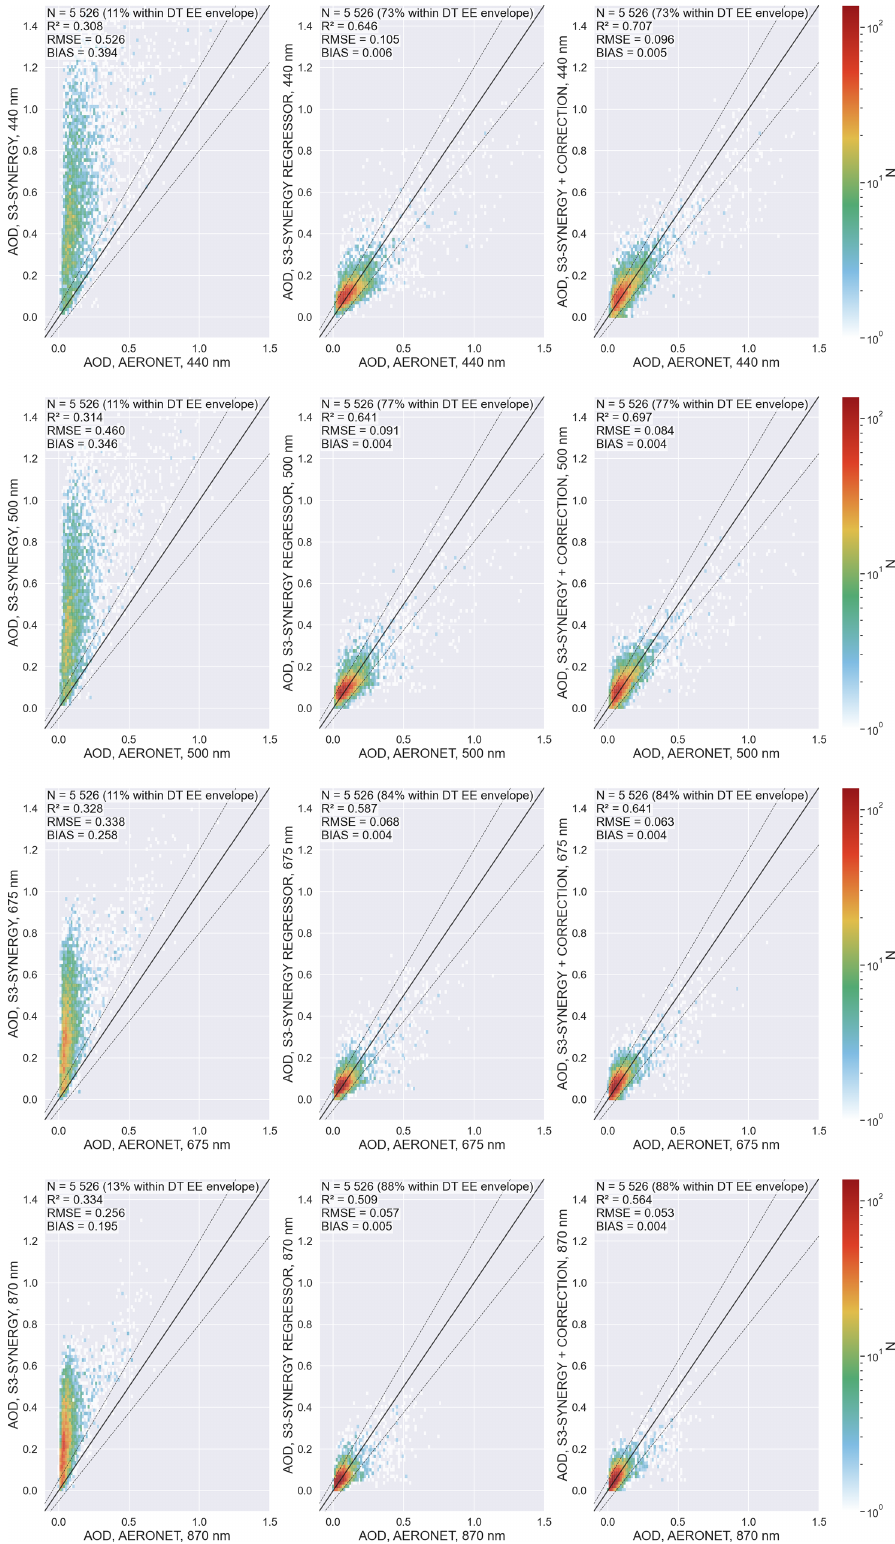
Figure 4. Estimated AODs at the wavelengths employed in the AERONET. Top to bottom: 440, 500, 675 and 870nm. Left: Sentinel-3 Level-2 Synergy AOD product. Middle: fully learned regressor model. Right: post-process